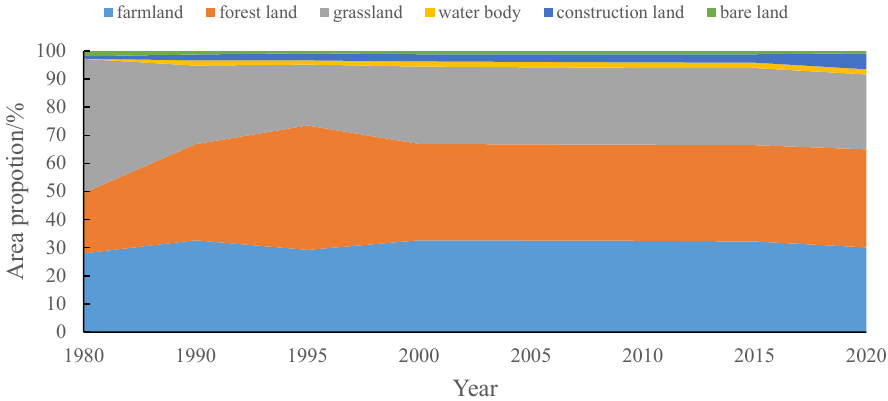
Figure 4. LULC change in the eight years during 1980–2020. Farmland was mainly distributed in the BSR and the junction of mountain and plain in the THM, and forest land was mainly distributed in the YSM and the junction of the THM and YSM, showing a trend of conversion of grassland to forest land during 1980 to 2020. Meanwhile, farmland in the junction of mountain and plain in the THM converted into construction land during 1980 to 2020. Since 2000, the spatial distribution of each LULC type changed slightly except the grassland in the BSR changed into forest land (Fig- ure 5). In general, the regional spatial distribution of LULC types varied widely, with for- est land dominating in the YSM, accounting for 49.06% of the total area, grassland, and farmland dominating in the THM, and both accounting for a similar proportion of the total area, being about 30%, while for the BSR, farmland dominated, accounting for about 50% of the total area.